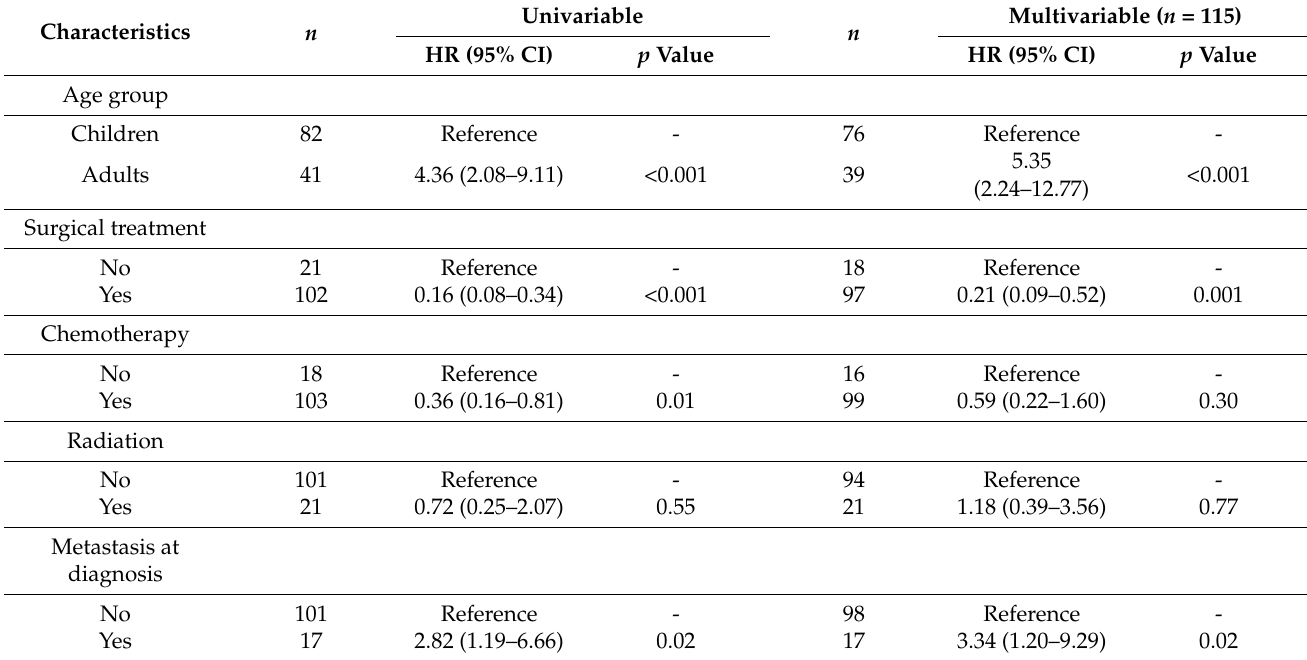
Table 2. Risk factors associated with mortality in the entire cohort.